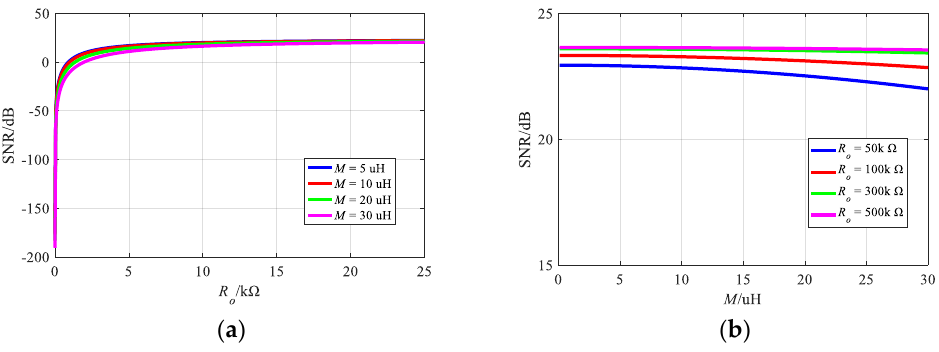
Figure 8. ( a ) The signal to noise rate (SNR) versus R o ; ( b ) SNR versus M.